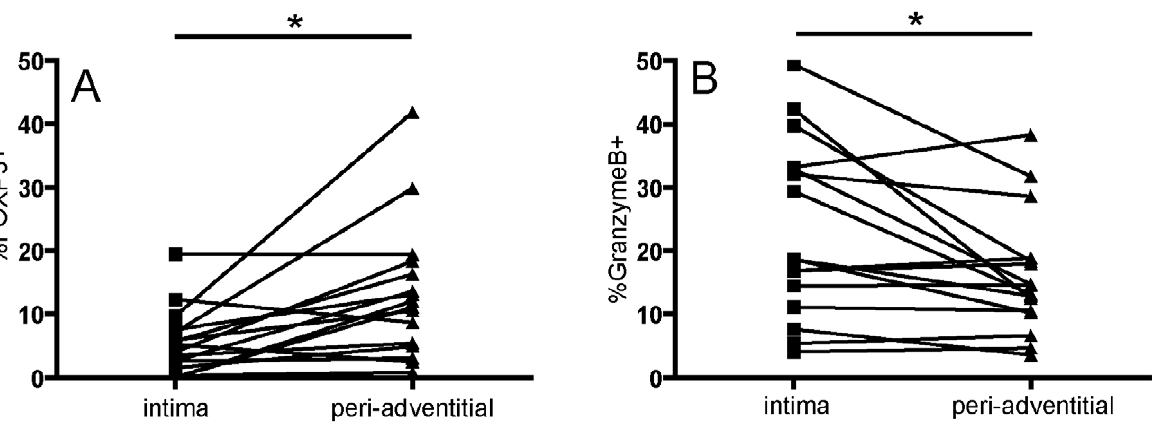
Figure 4. Differences between intra- and extravascular functional T cells subsets in renal allograft vasculopathy. A: numbers of FOXP3 + T cells, expressed as a percentage of the total number of CD3 + T cells. B: numbers of GrB + T cells, expressed as a percentage of the total number of CD8 + cells. *: p , 0.05, paired T test.